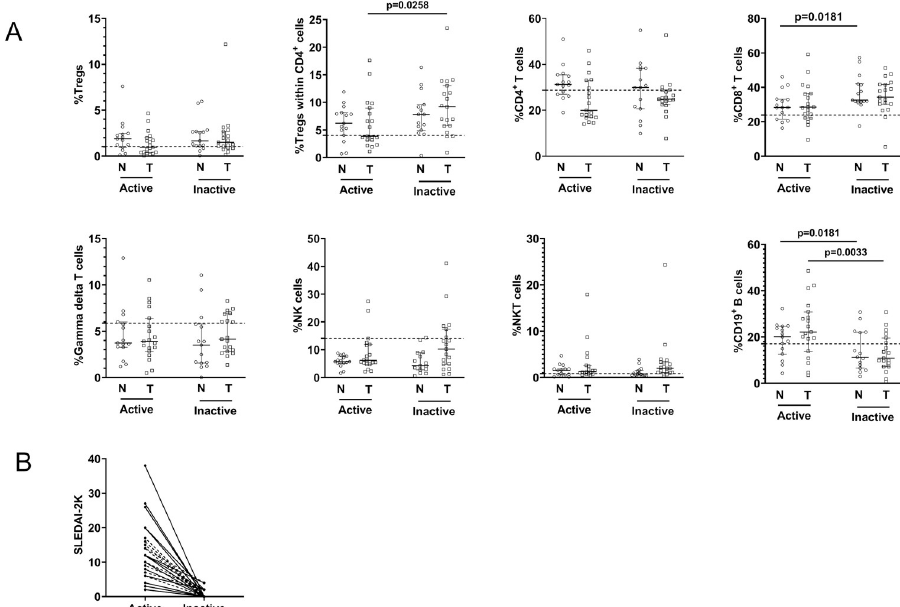
Fig 4. Lymphocyte subset distribution during longitudinal follow-up in JSLE patients, stratified into treatment- na ï ve and treated groups. (A) Percentages of lymphocyte subsets in 34 JSLE patients during active disease and follow- up until inactive disease (treatment-na ï ve patients = 15, treated patients = 19), (B) Disease activity measured by SLEDAI-2K during active disease and follow-up until inactive disease in 34 JSLE patients. Horizontal solid lines represent medians and interquartile ranges. The dashed horizontal lines in (A) show the medians for healthy controls. The dashed lines in (B) represent individual treatment-na ï ve patients, and solid lines in (B) represent individual treated patients. JSLE, juvenile-onset systemic lupus erythematosus; Tregs, regulatory T cells; NK cells, natural killer cells; NKT cells, natural killer T cells; N, treatment-na ï ve patients; T, treated patients; SLEDAI-2K, systemic lupus erythematosus disease activity index